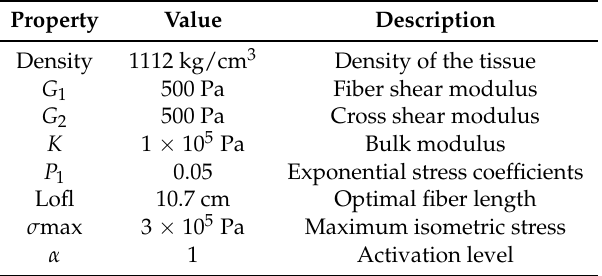
Table 3. Properties used for the material model solved with the Finite Element Method (FEM).